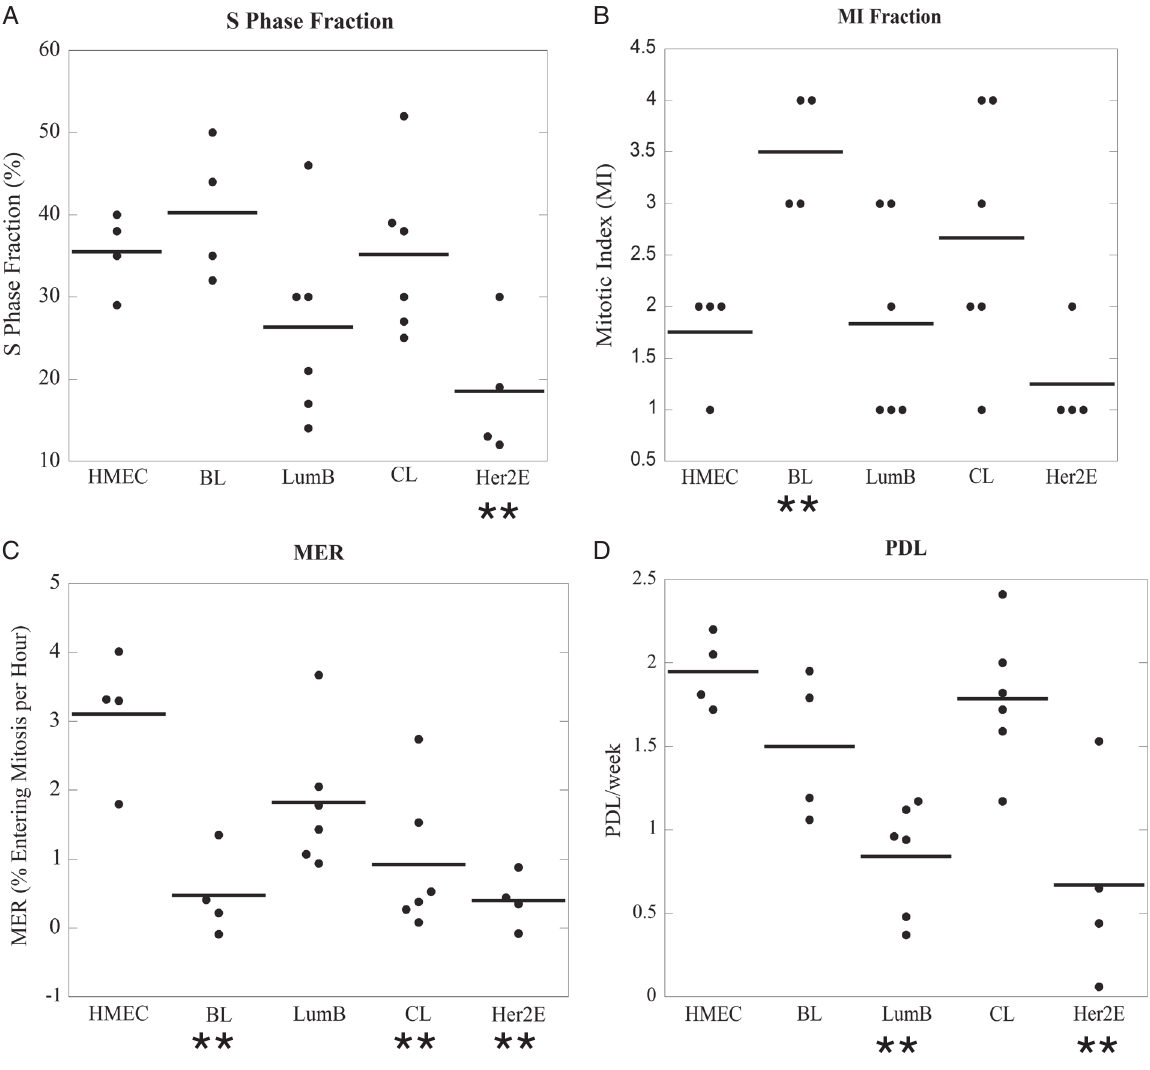
Fig. 3 S/G 2 /M progression is aberrantly regulated in breast cancer cell lines of all classes. The average percentage of cells in S phase (a) or mitosis (b) and the MER (c) is shown for each cell line and grouped according to intrinsic molecular subtype. Each point represents the average of at least three independent experiments for an individual cell line, and the bold lines represent the class average. The Her2E class exhibited a lower S phase fraction, the BL class demonstrated a higher MI, and the BL, CL, and Her2E classes displayed lower MERs when compared to the HMEC class. d The population doubling level (PDL) over at least 11 weeks in cell culture was determined for each cell line, and the bold lines represent the class averages; both the LumB and Her2E classes exhibited low PDLs. * p -value < 0.05, ** p -value that remains signi fi cant when controlling for false discovery rate